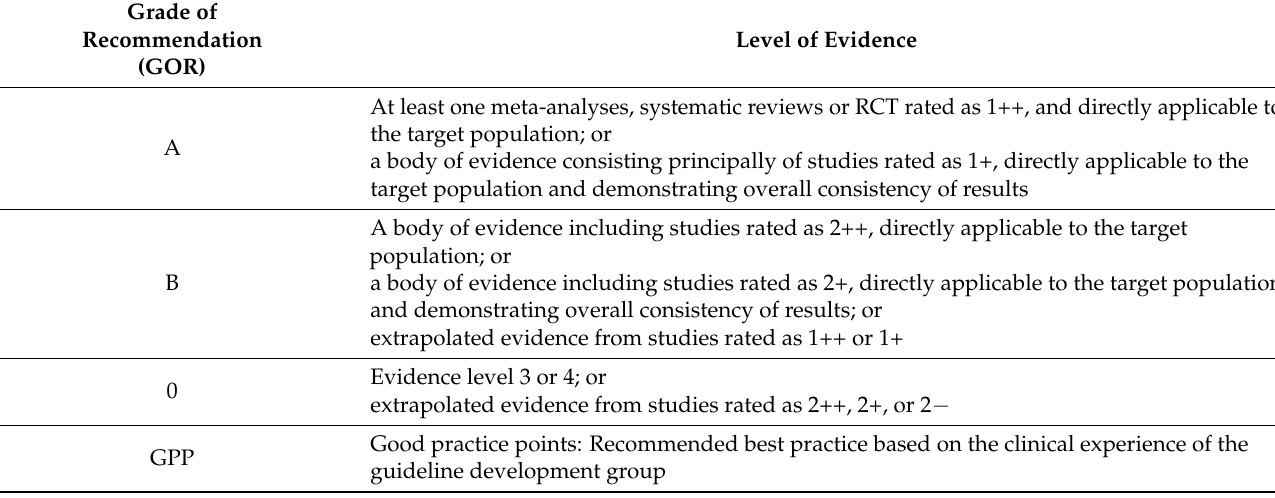
Table 3. Rating scheme for the strength of the recommendation [11,16].